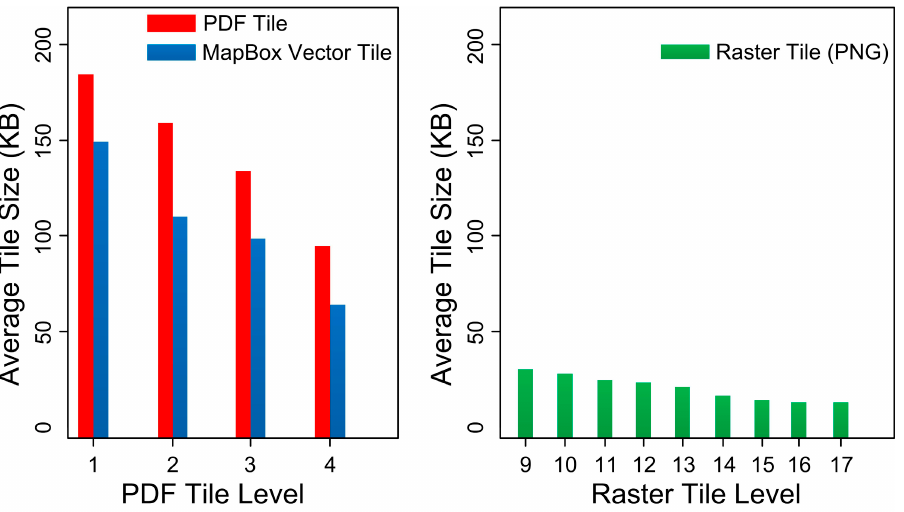
Figure 21. The average tile size of three different types at different levels.